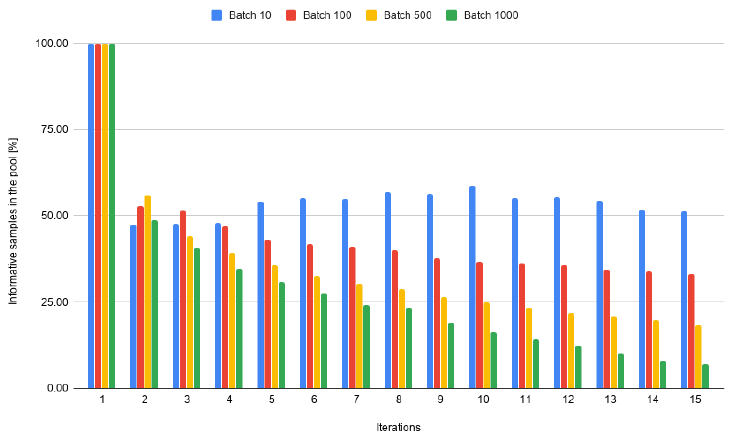
Figure 5. Ratio of informative samples to all samples in the training pool for given batch